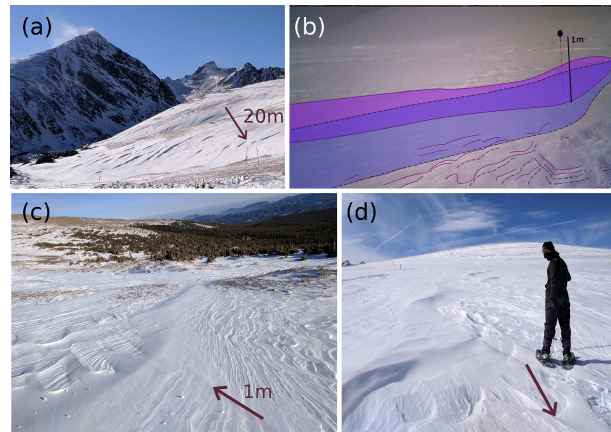
Figure 8. Snow waves on Niwot Ridge, Colorado. (a) Long- distance view on 9 November 2017 with estimated wind direction and scale, (b) time-lapse image showing motion of wave (shaded) and small erosional features (lines) away from the camera from 12:20 (dashed blue area) to 13:00 (purple, solid) on 24 February 2017, video S1 at 4:19, (c) parallel snow steps in the wake of a wave on 9 November 2017, and (d) alternating wave crests and ripples on 12 November